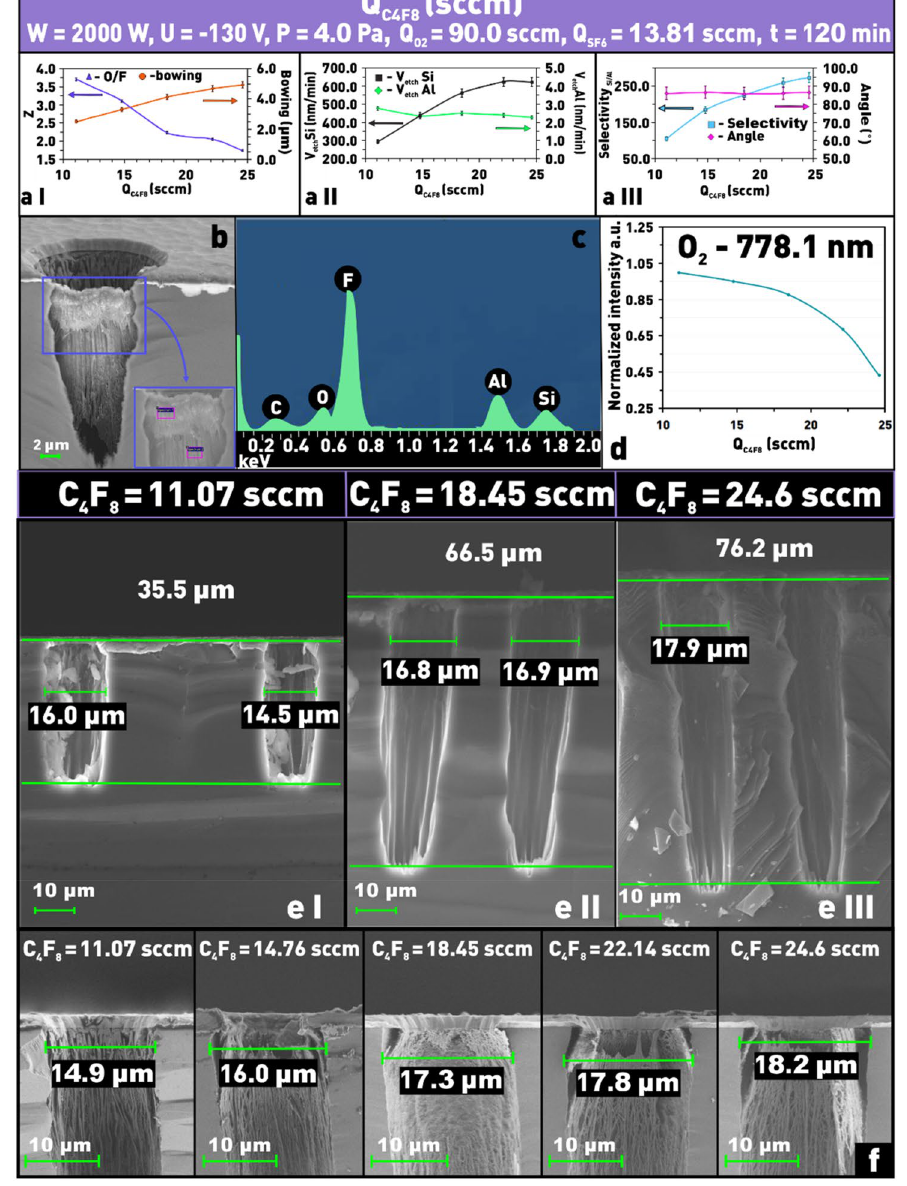
Figure 6. Dependences on C 4 F 8 flow rate in SF 6 /C 4 F 8 /O 2 plasma: ( a I ) of δ and Z; ( a II ) of silicon and aluminum etching; ( a III ) of etch selectivity and Θ angle; ( b ) microphotograph of protective layer after the PCE process; ( c ) EDS of protective film; ( d ) intensity of 778.1 nm line as a function of C 4 F 8 flow rate; ( e I – III ) microphotographs of etching profiles at different contents of C 4 F 8 in SF 6 /C 4 F 8 /O 2 plasma; ( f ) microphotographs of etched windows at different contents of C 4 F 8 in SF 6 /C 4 F 8 /O 2 plasma to evaluate the structure overetching